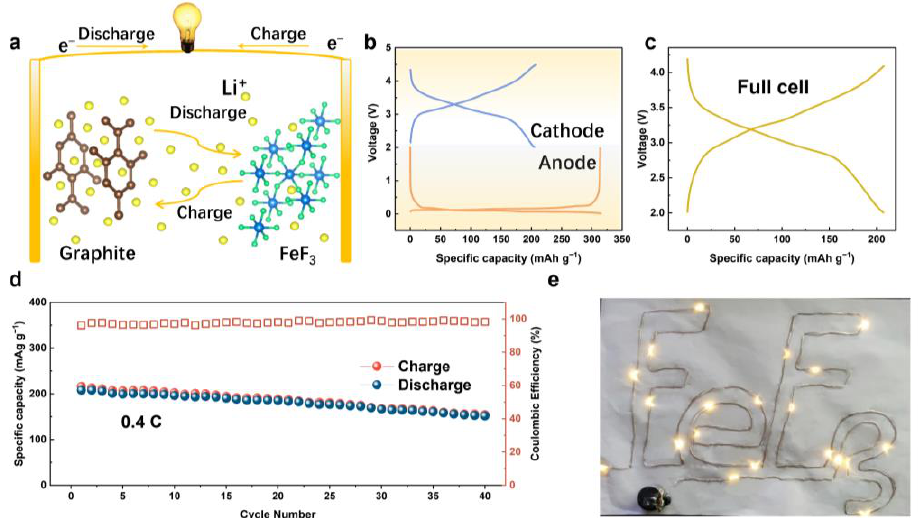
Figure 6. Electrochemical performance of full cell system coupling FeF 3 @C as cathode material and graphite as anode material. ( a ) Schematic showing the charge/discharge process. ( b ) The galvanostatic charge/discharge curves versus the specific capacity of FeF 3 @C cathode and a graphite anode. ( c ) The galvanostatic charge/discharge curves versus the specific capacity of the full cell. ( d ) Cycling performance during 40 cycles at 0.4 C. ( e ) Shows a photograph of the LEDs lit up by the full cell.